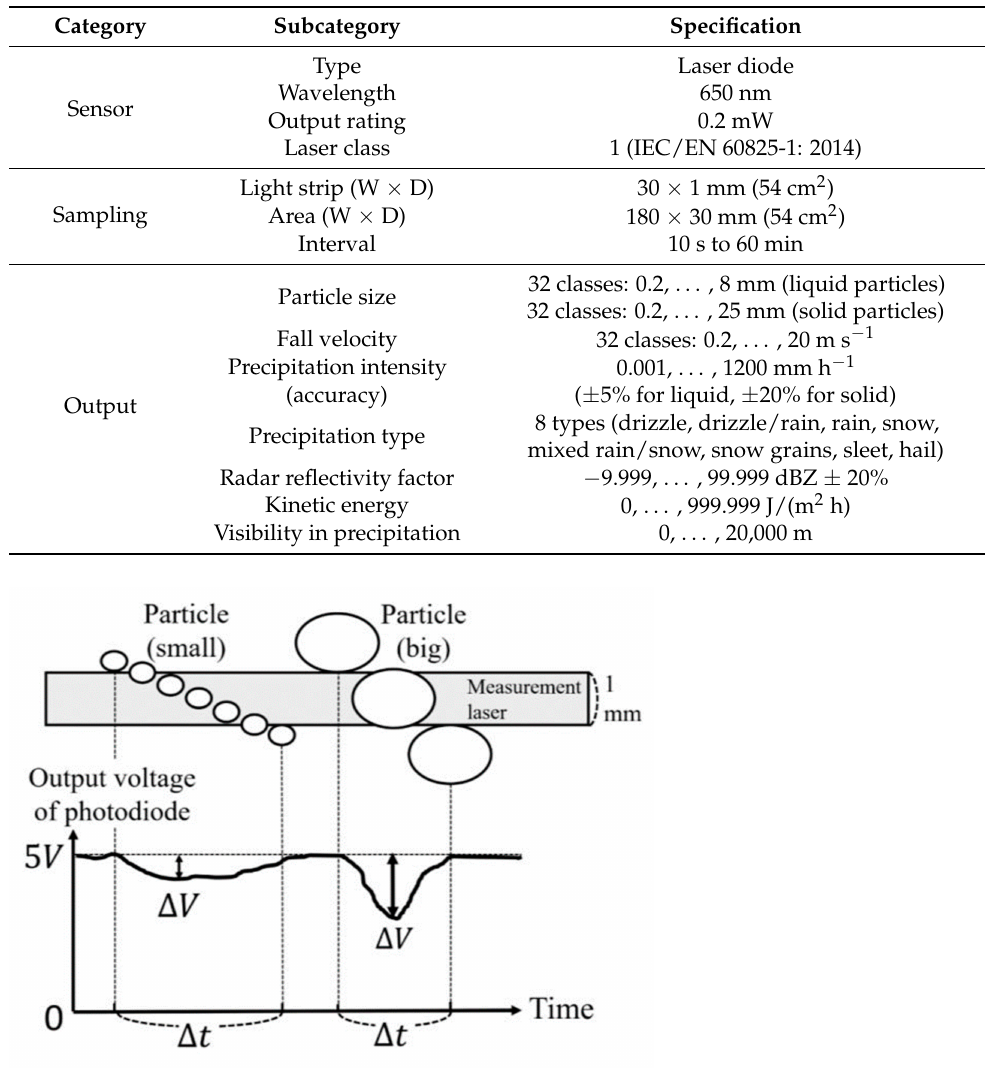
Table 1. Main specifications of the Parsivel 2 disdrometer, according to the instruction manual (OTT, 2011).